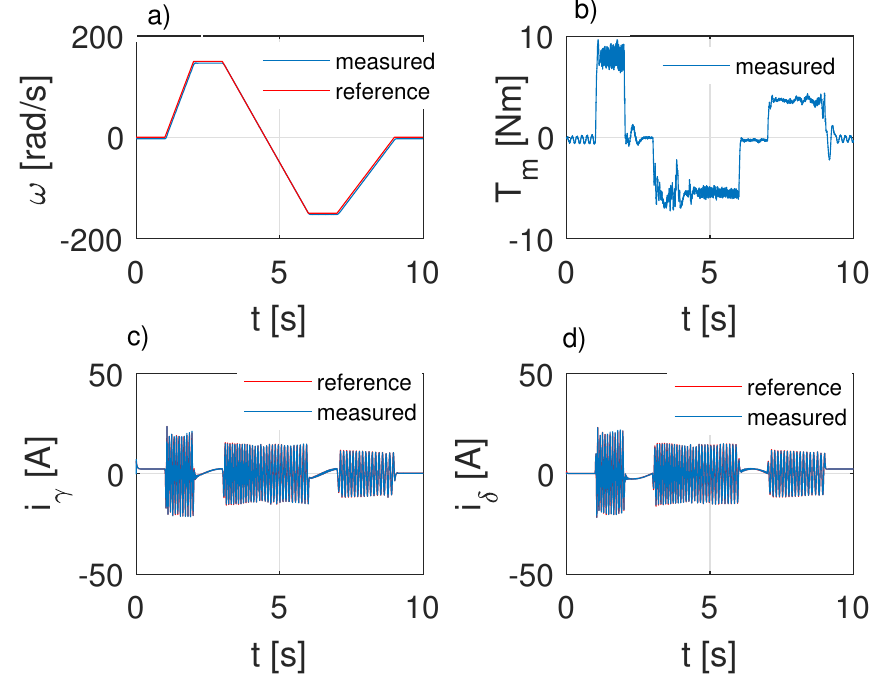
Figure 9. Control performance for the speed reversal command: speed response ( a ), measured torques ( b ), and reference and measured stator current vector components ( c , d